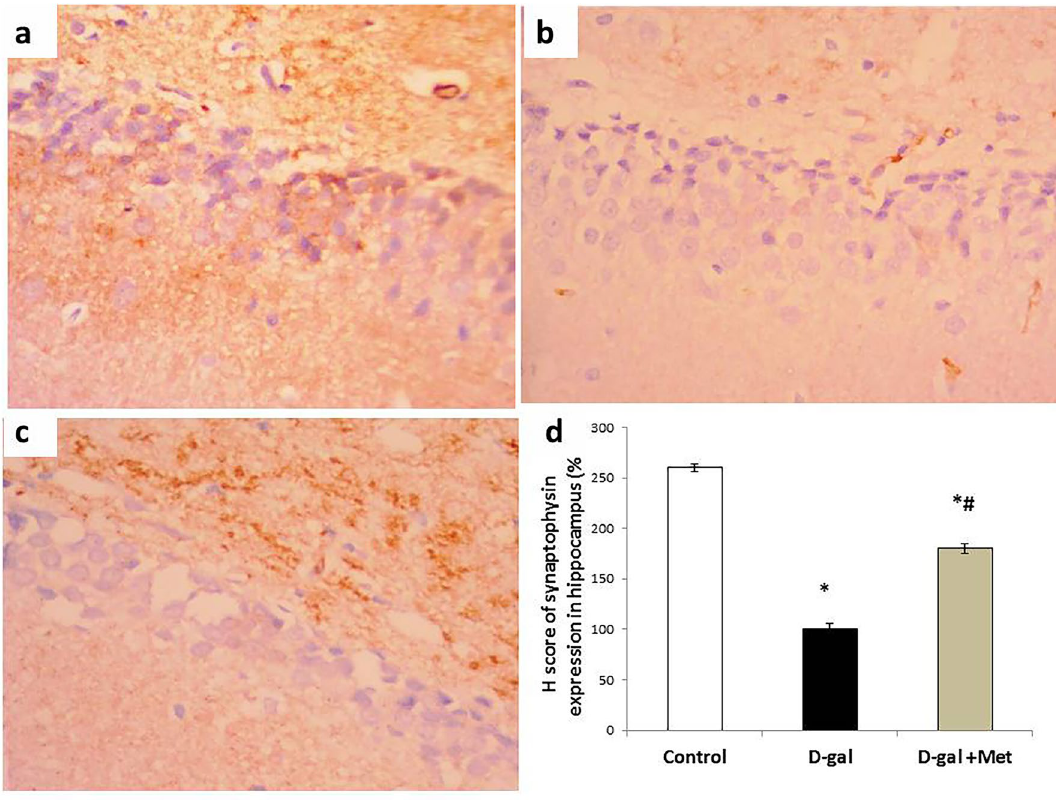
Figure 8. Synaptophysin immunostaining in hippocampal tissues of the studied groups. ( a ) Section of the hippocampal tissue in the control group showed intense cytoplasmic expression of synaptophysin in neural cells. ( b ) Section of the hippocampal tissue in the D-gal group showed mild cytoplasmic expression of synaptophysin in neural cells. ( c ) Section of the hippocampal tissue in the D-gal + Met group showed moderate cytoplasmic expression of synaptophysin in neural cells (Synaptophysin × 200 for A, B and C). ( d ) Represents the percentage of synaptophysin expression in the above-mentioned groups (*significant when compared to control group, # significant when compared to D-gal group). Data are shown as means + SD (n = 10). ANOVA was used to make group comparisons; Significance = P <